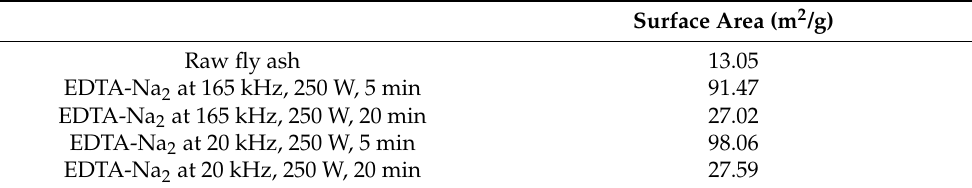
Table 4. Surface area of fly